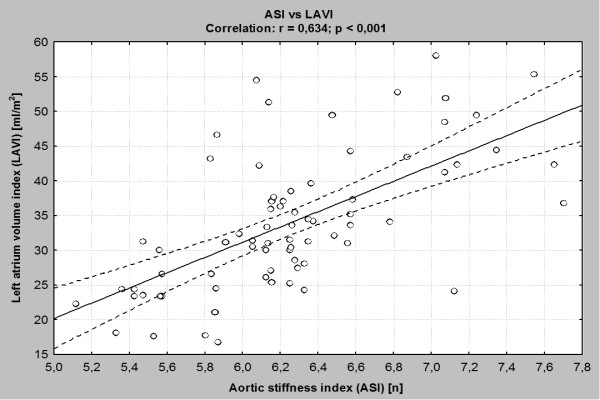
The association between ASI and LAVI.